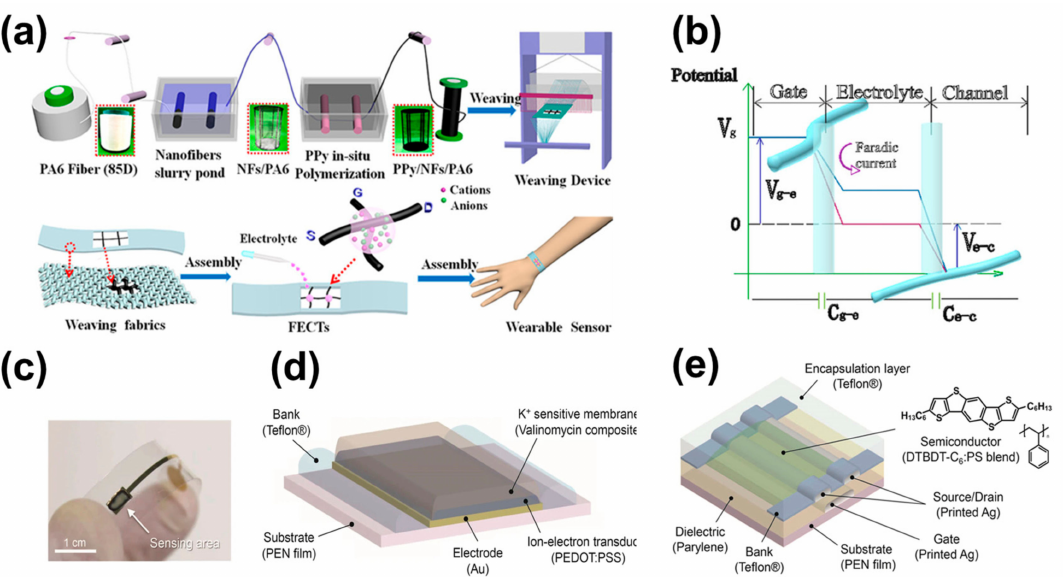
Figure 6. ( a ) Wearable biosensor for detecting dopamine sketch. ( b ) Potentiogram of FECTs based on the presence or absence of dopamine. The red line shows the absence of dopamine, and the blue line shows the presence of dopamine. ( c ) Diagrammatic representation of the sensitive electrode. ( d ) Illus- tration of the structure of the sensitive electrode. ( e ) Schematic representation of the composition of OTFTs. ( a ) Reproduced with permission [45]. Copyright 2019, American Chemical Society. ( b ) Re- produced with permission [45]. Copyright 2019, American Chemical Society. ( c ) Reproduced with permission [46]. Copyright 2018, Springer Nature. ( d ) Reproduced with permission [46]. Copyright 2018, Springer Nature. ( e ) Reproduced with permission [46]. Copyright 2018, Springer